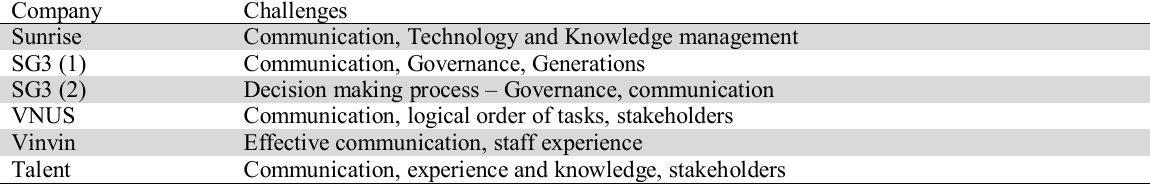
The challenges of effective implementation of